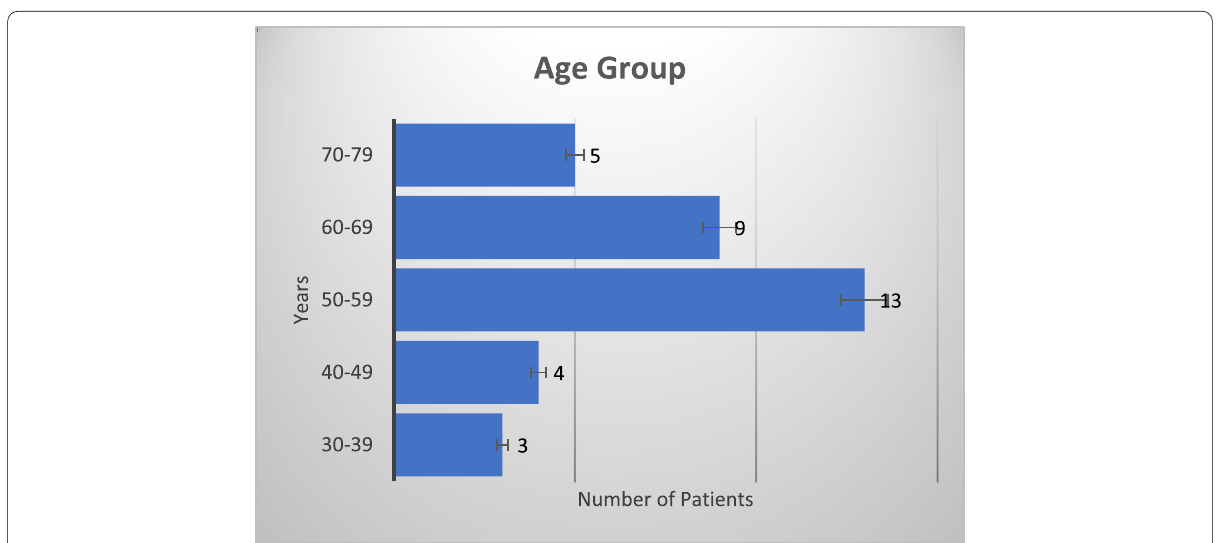
Fig. 1 Distribution of 34 female cases of laryngeal cancer according to age